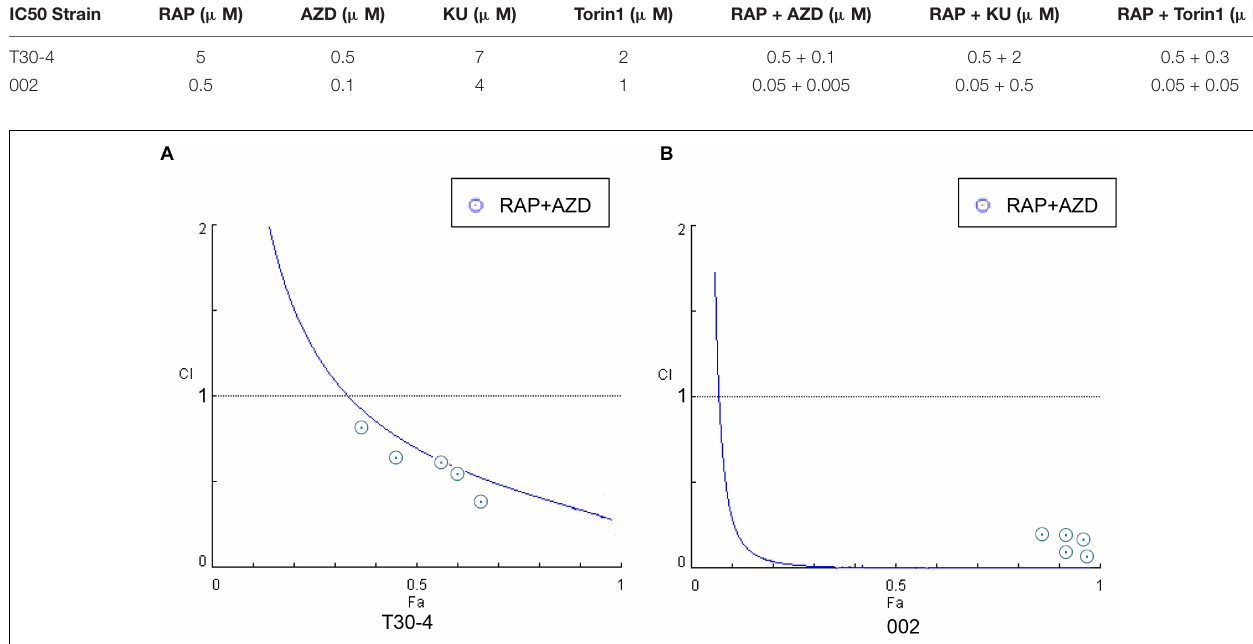
TABLE 1 | IC50 values of TOR inhibitors on P. infestans T30-4 and 002.